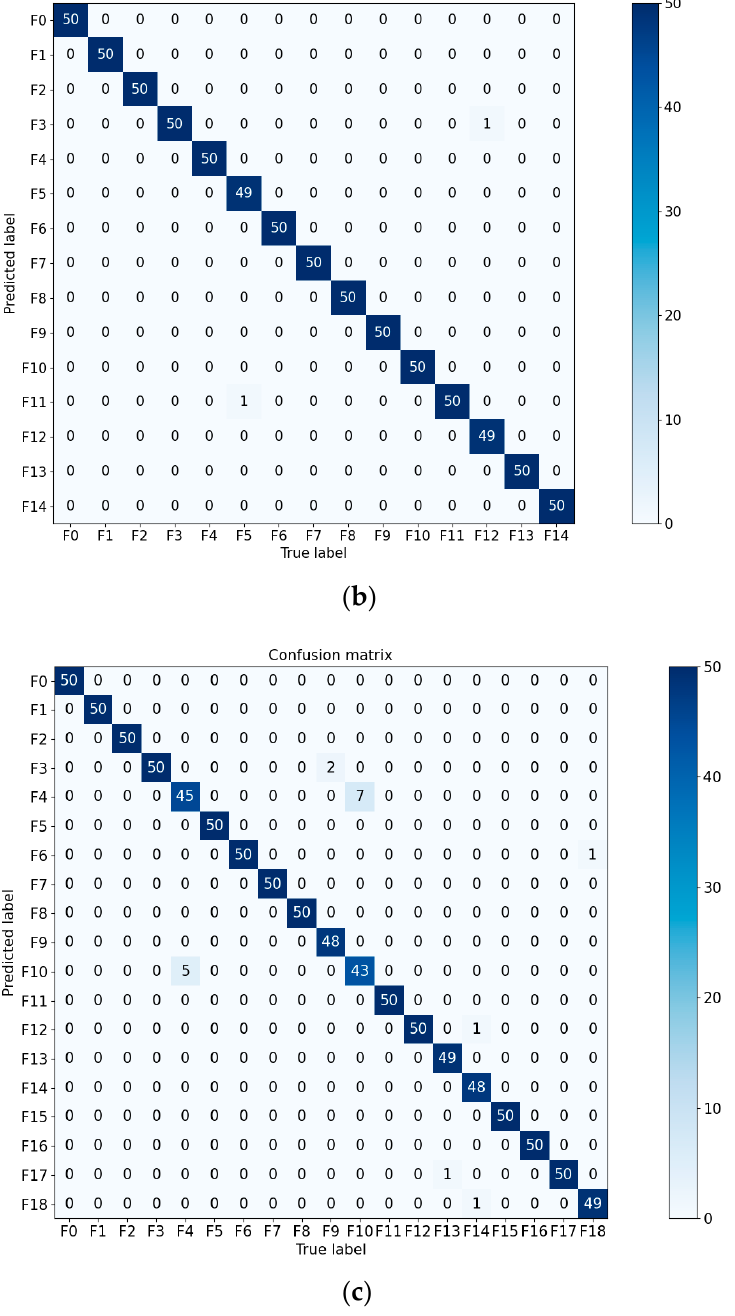
Figure 14. Confusion matrix. ( a ) Confusion matrix of the Sallen–Key bandpass filter circuit response; ( b ) confusion matrix of the CSTV filter circuit response; and ( c ) confusion matrix of the leap-frog low-pass filter circuit response.